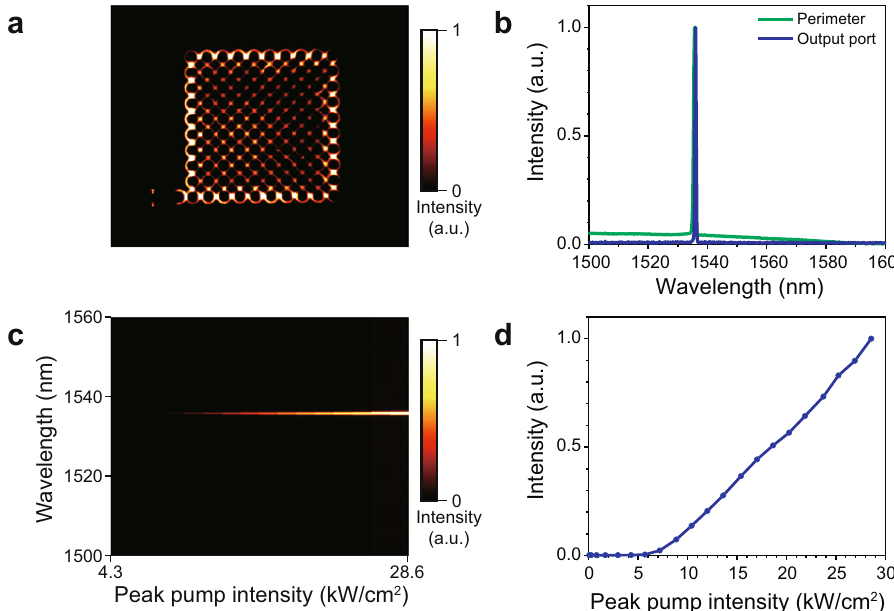
Fig. 2 Topological edge mode lasing under optical pumping. a Photoluminescence image from the topological laser array when only its perimeter is pumped. b Emission spectra from the grating output coupler and a site on the perimeter at a pump intensity of 15.4 kW/cm 2 . c Evolution of the spectrum as a function of the peak pump intensity. The single-mode emission with the narrow linewidth is attributed to the topological edge mode. a.u., arbitrary units. d Measured output intensity as a function of the peak pump power. The data presented in c and d were collected from the output port (grating).